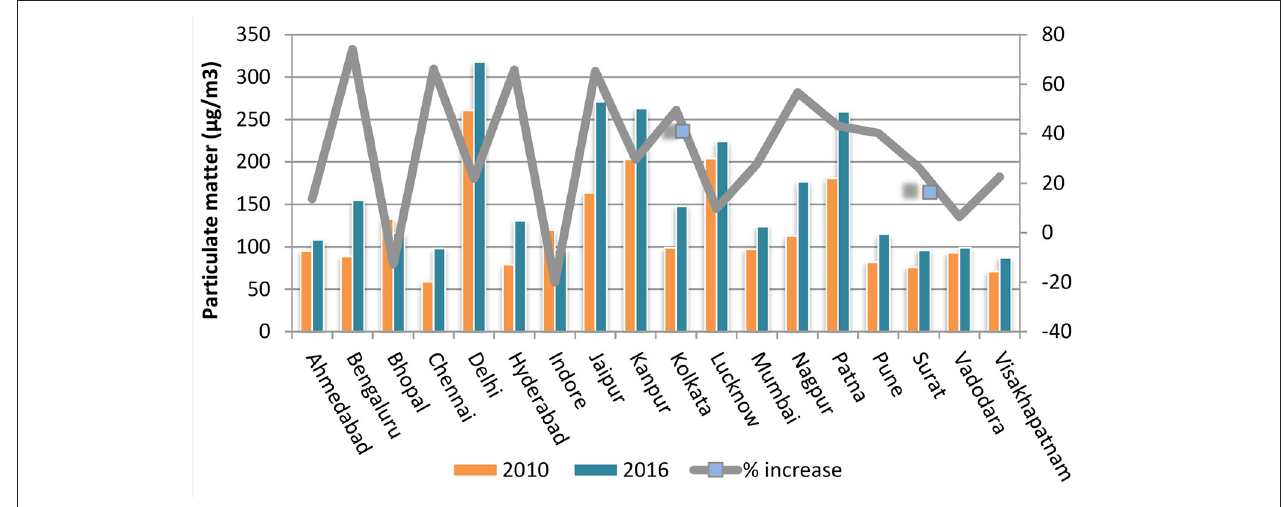
FIGURE 2 | The % increase in particulate matter concentrations for Indian megacities.